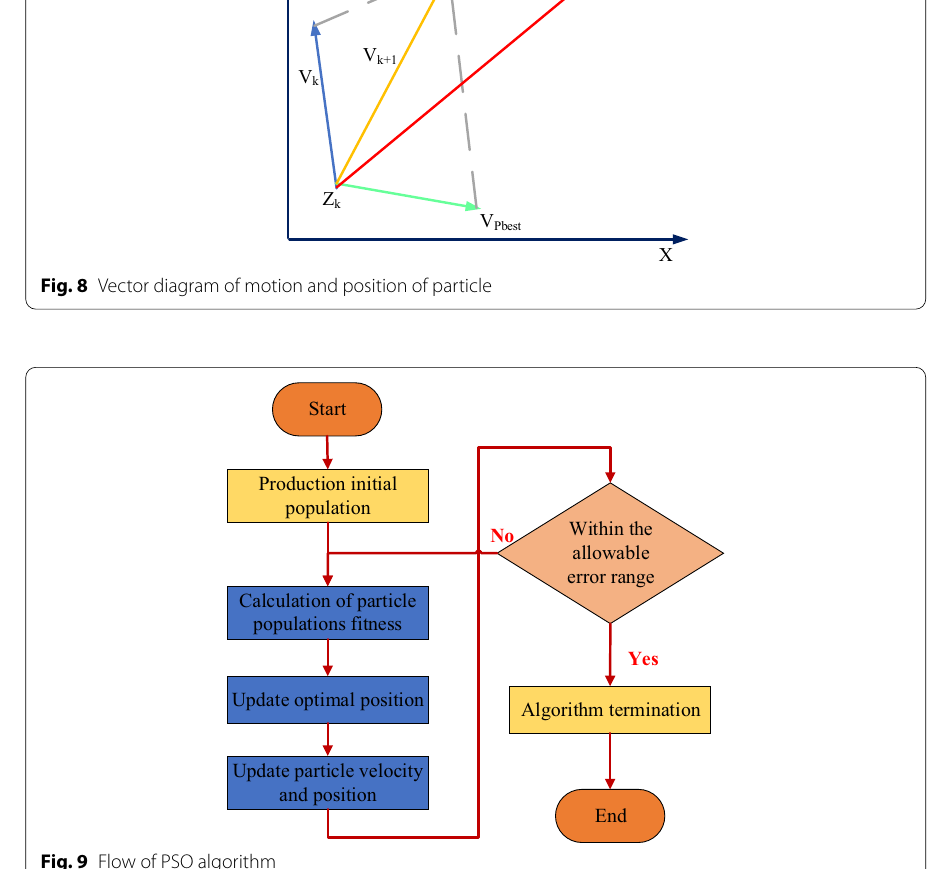
Fig. 9 Flow of PSO